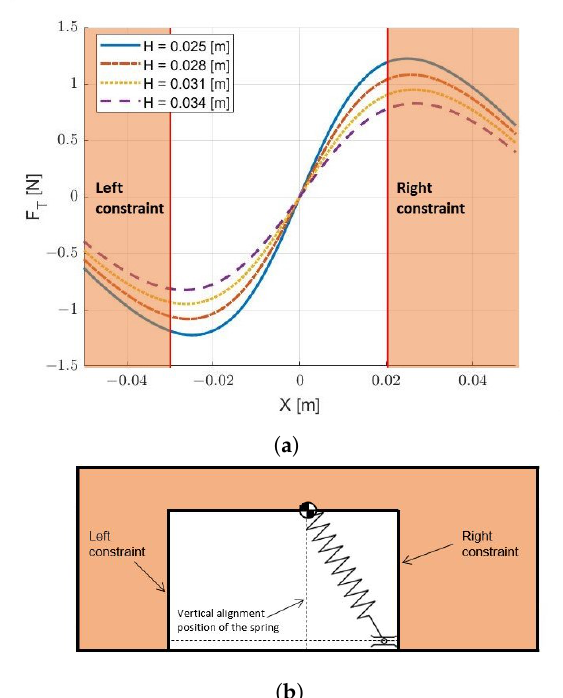
Figure 22. ( a ) Tangential force profiles for different values of the parameter H; ( b ) physical representation of mechanical